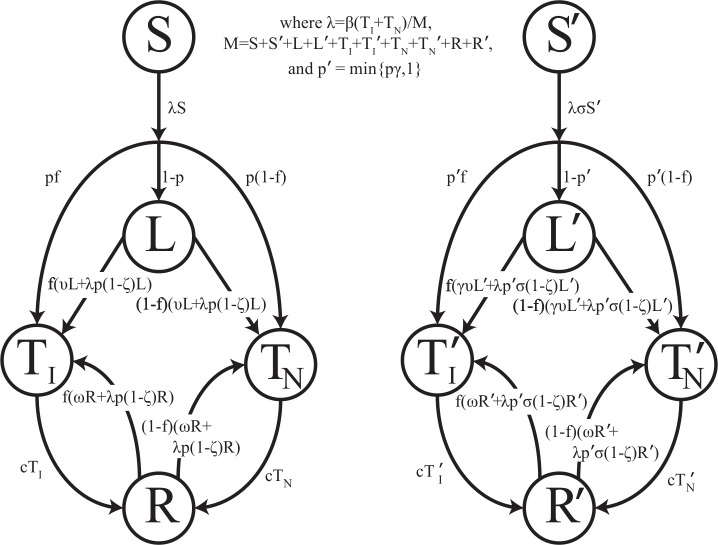
Transmission diagram.Representation of compartmental TB models 0, 1, 2, and 3. Individuals who are more genetically susceptible are in the primed states, whereas less genetically susceptible individuals are in the unprimed states. S, L, TI, TN, and R represent the numbers of people in the susceptible, latent, infectious active disease, non-infectious active disease, and recovered groups, respectively, as a function of time for the less susceptible group. S′, L′, \documentclass[12pt]{minimal}
\usepackage{amsmath}
\usepackage{wasysym} 
\usepackage{amsfonts} 
\usepackage{amssymb} 
\usepackage{amsbsy}
\usepackage{upgreek}
\usepackage{mathrsfs}
\setlength{\oddsidemargin}{-69pt}
\begin{document}
}{}${T}_{I}^{{\prime}}$\end{document}TI′, \documentclass[12pt]{minimal}
\usepackage{amsmath}
\usepackage{wasysym} 
\usepackage{amsfonts} 
\usepackage{amssymb} 
\usepackage{amsbsy}
\usepackage{upgreek}
\usepackage{mathrsfs}
\setlength{\oddsidemargin}{-69pt}
\begin{document}
}{}${T}_{N}^{{\prime}}$\end{document}TN′, and R′ represent the numbers of people in the susceptible, latent, infectious active disease, non-infectious active disease, and recovered groups, respectively, as a function of time for the more susceptible group. Model parameters are given in Table 1. For models 0 and 1, no individuals start out in S′, and thus all primed states remain empty. For models 2 and 3, a fraction of individuals start in S′. For model 2, σ ≠ 0 and y = 0. For model 3, σ = 0 and y ≠ 0. For simplicity, background mortality and TB specific mortality were omitted from the diagram.